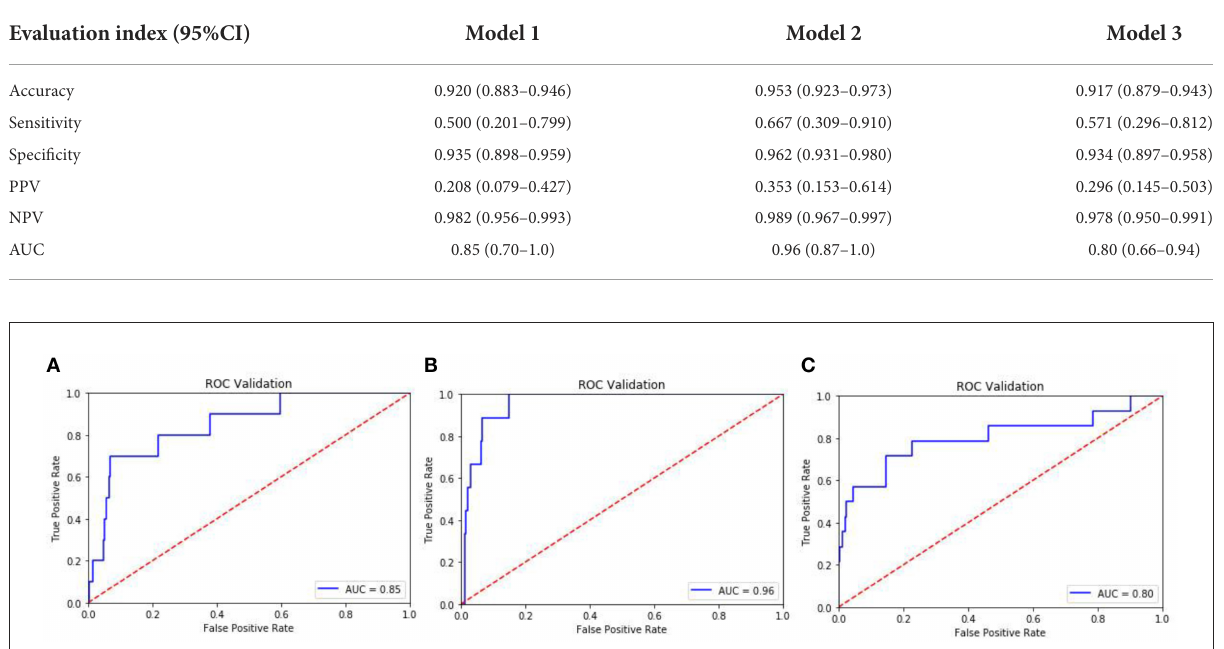
TABLE 3 Discrimination performances for the prediction models.